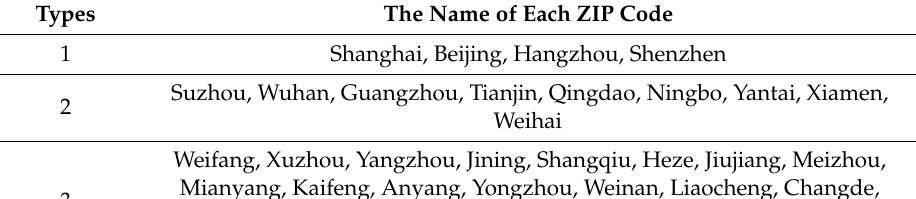
Table 3. The cluster analysis results of urban photovoltaic applications at the ZIP code level. Types The Name of Each ZIP